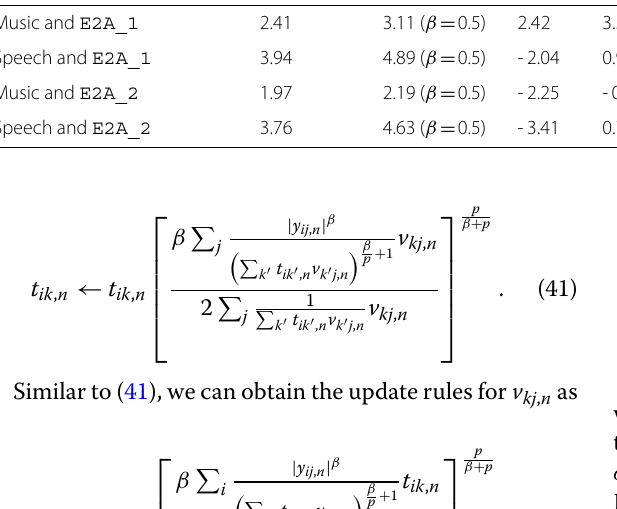
Table 5 Overall average SDR improvements (dB) in two-source case for the best parameter settings Source and impulse response